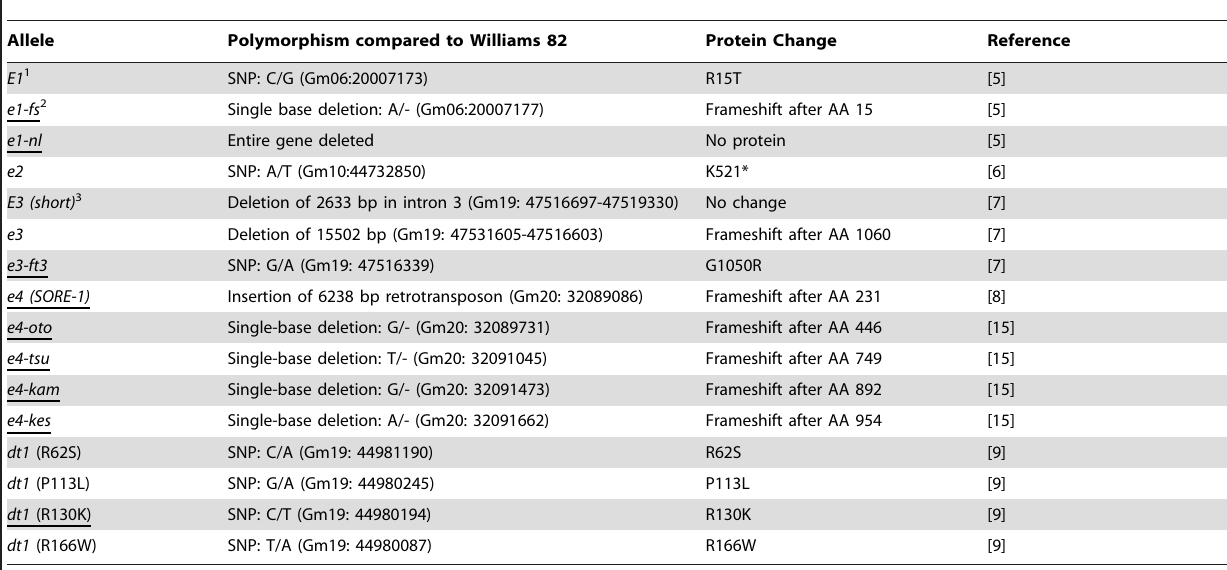
Table 2. Reported polymorphic alleles of major maturity genes with reference to the Williams 82 sequence.